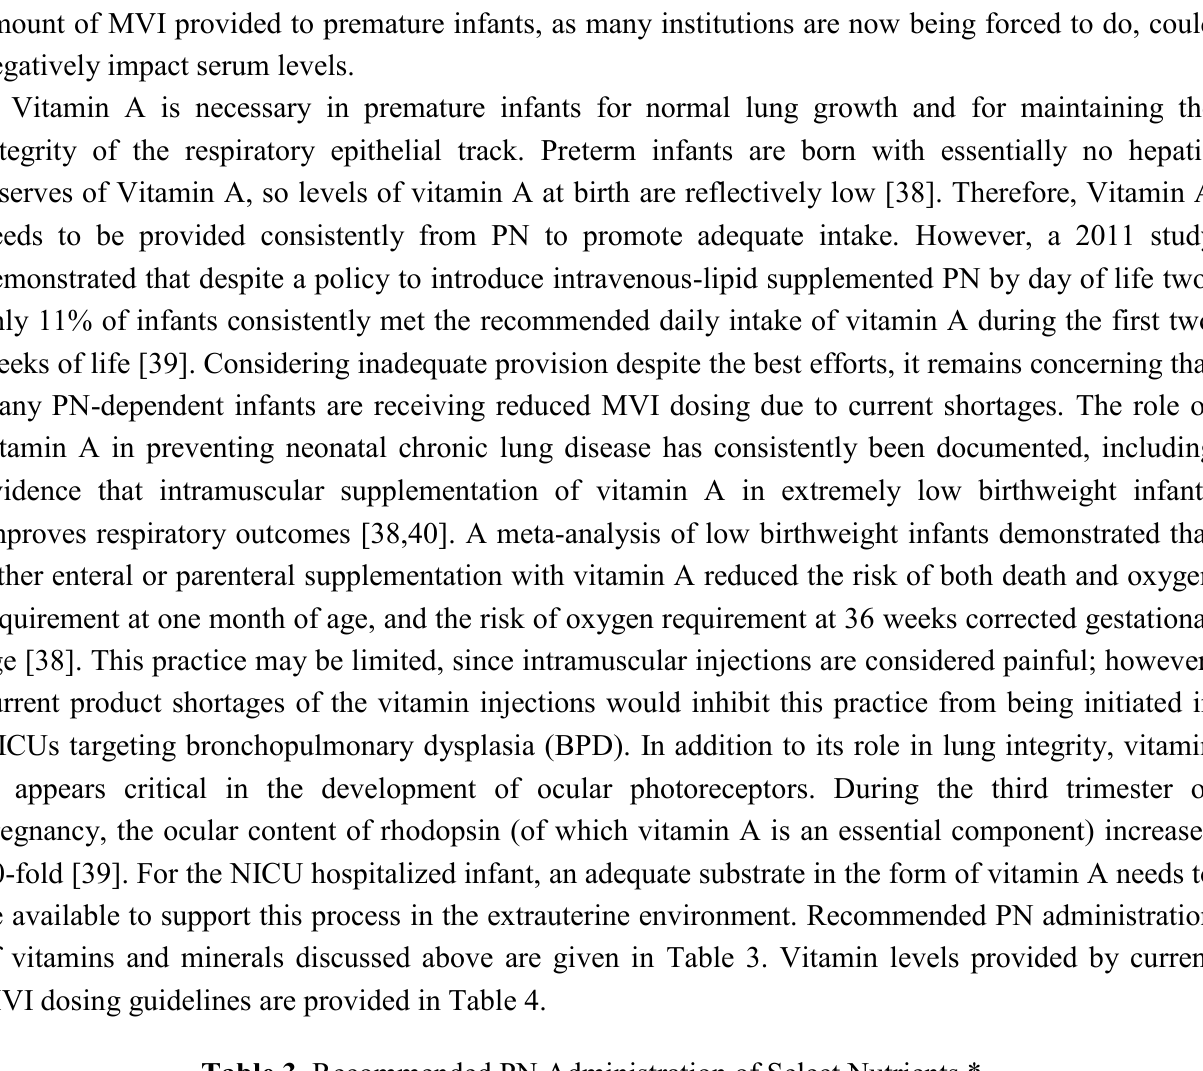
Table 3. Recommended PN Administration of Select Nutrients